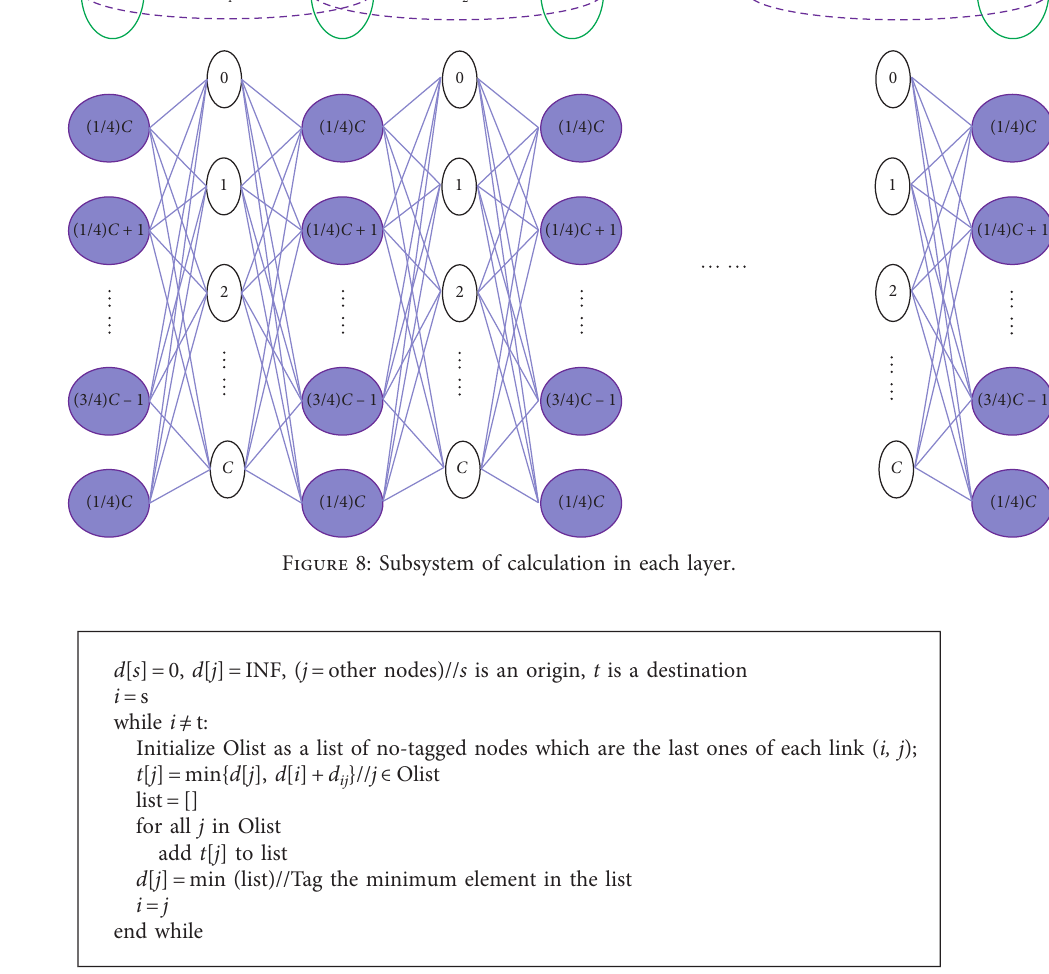
A LGORITHM 1: Pseudocode of the